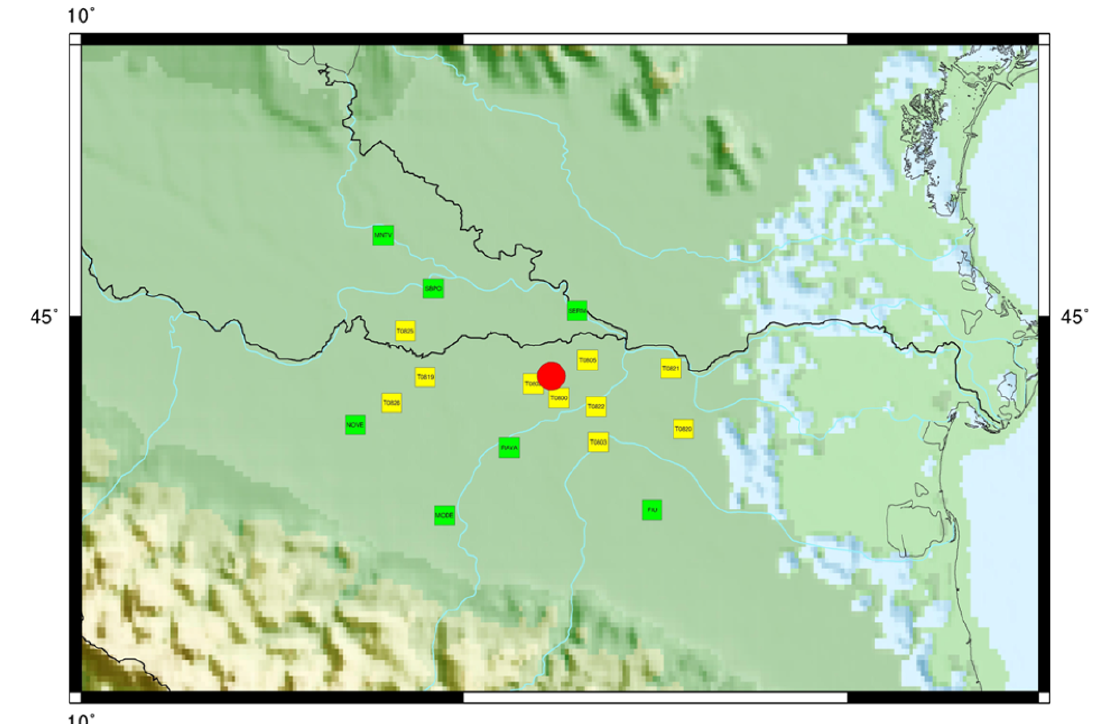
Figure B1. Map of the permanent (green) and portable (yellow) seismic stations in the area of the Emilia seismic sequence.